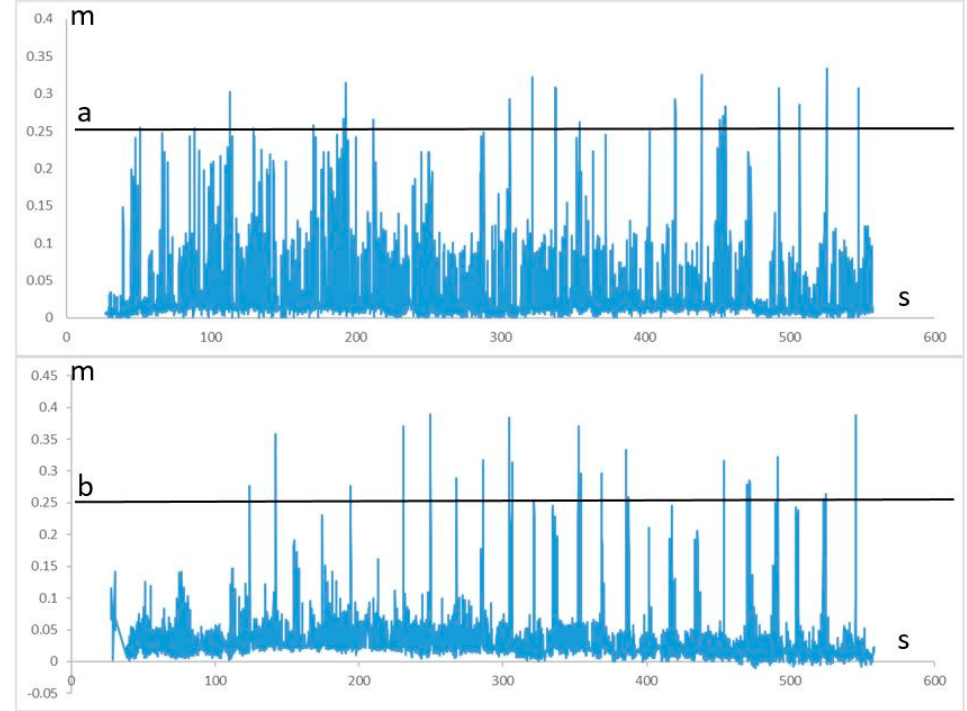
Figure 4. Trajectory of movement during AR-Rehabilitation on the 1 and 10-day sessions (patient from A-Rehab-Traditional-AR as an example); ( a ) 1st session and ( b ) 10th session. Height of raising the left foot during execution of the test of the Balance domain: black line—height of virtual obstacle, blue line—Y coordinate of left foot. Comparisons of movement parameters between 1st and 10th motor sessions: Height of raising the paretic leg: P 1–10 = 0.003 *. Variance of the displacement for the central point: P 1–10 < 0.001 *. * Significant; p <